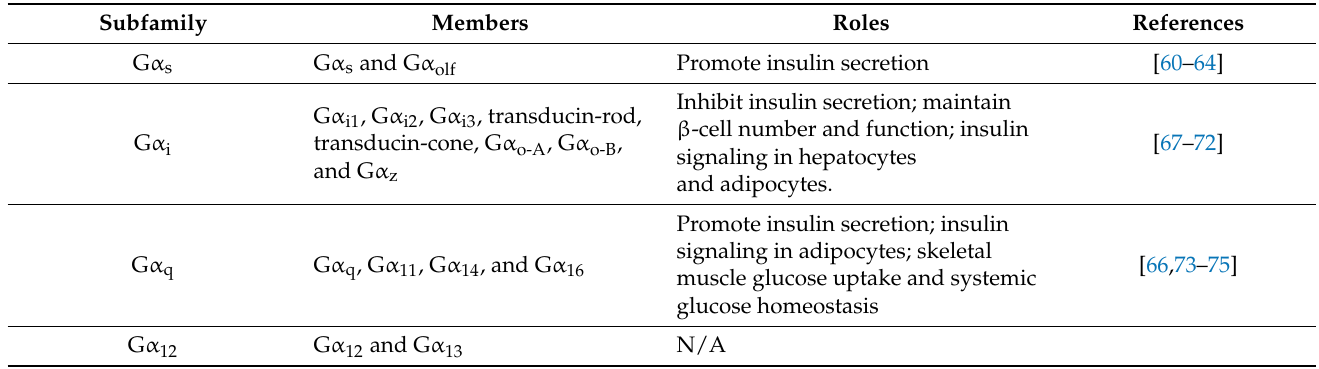
Table 2. Summary of G α subfamily members and their roles in